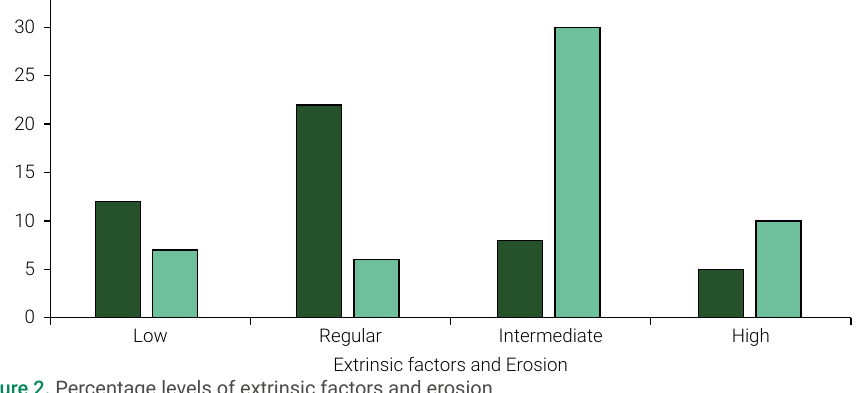
Figure 2. Percentage levels of extrinsic factors and erosion.